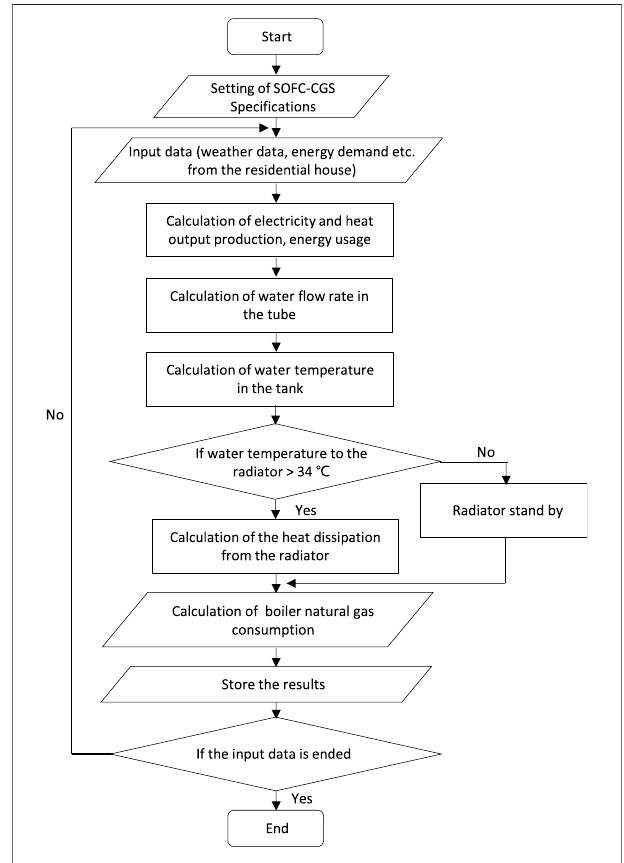
FIGURE 4 | Calculation fl owchart of the SOFC – CGS model.